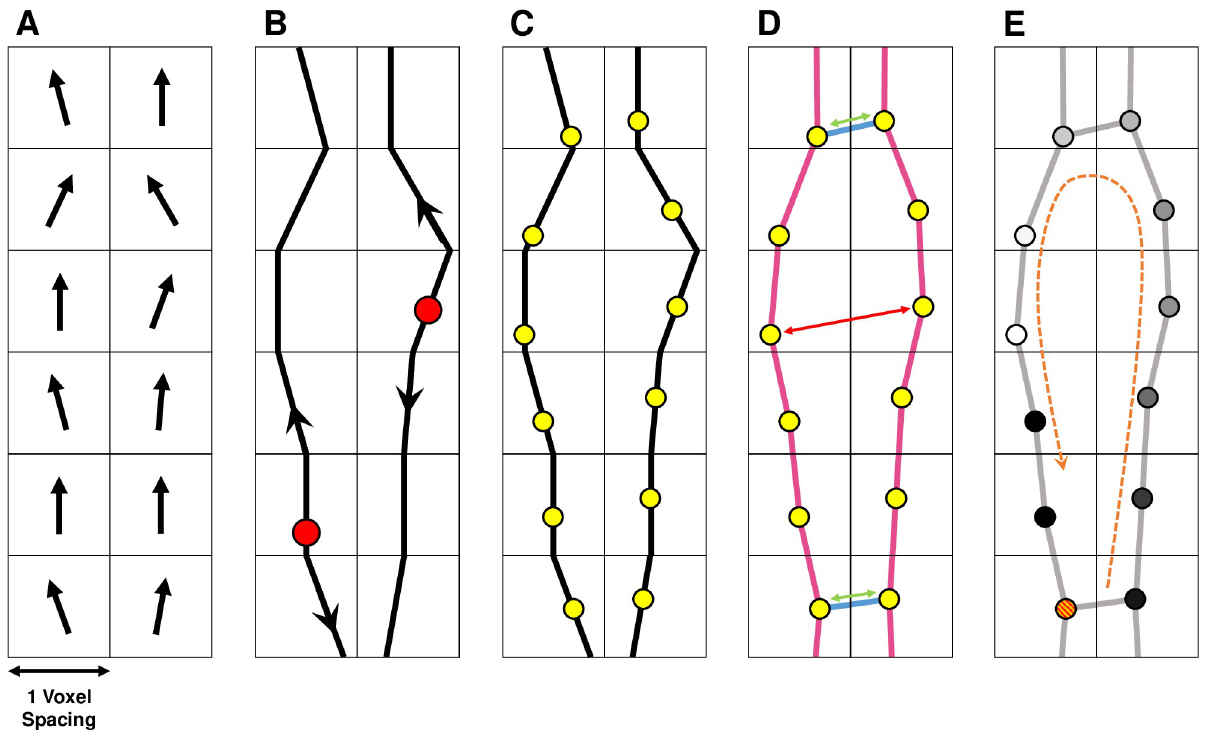
Fig 3. A 2D schematic showing the conversion of local fibre orientation vectors into global fibre tracts which are seeded with nodes and coupled into a spatial network. (A) Each image-based model provides a vector field for the local fibre orientation. (B) Beginning from a set of random seed points (red circles), fibres are generated using tractography, propagating forward and backwards in the direction of the local orientation vector. (C) Nodes (yellow circles) are placed at approximately equal intervals along the fibres. (D) Nodes are coupled to neighbouring nodes with probability 1 if nodes are adjacent and in the same fibre (pink edges), and according to a monotonically decreasing function of distance, p ( x ; r , c ), otherwise (blue edges). Nodes which are close together (green arrows) are more likely to be connected than those which are far apart (red arrows). (E) By applying a discrete diffusion model (see section 3.4) to the network, we identify the micro-reentrant substrate by observing where conduction block (red/orange circle) results in a wavefront (white circle) reentering a blocked fibre.